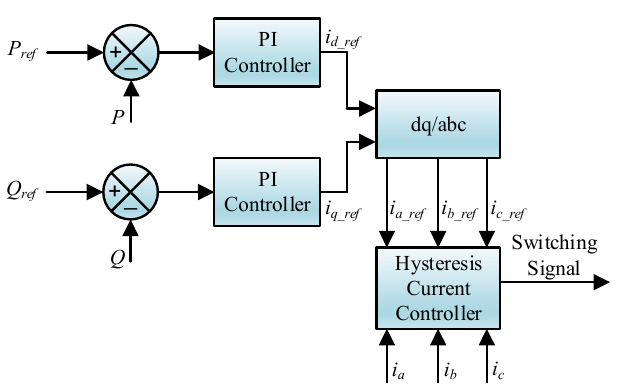
Figure 4. Schematic diagram of charging station converter control.